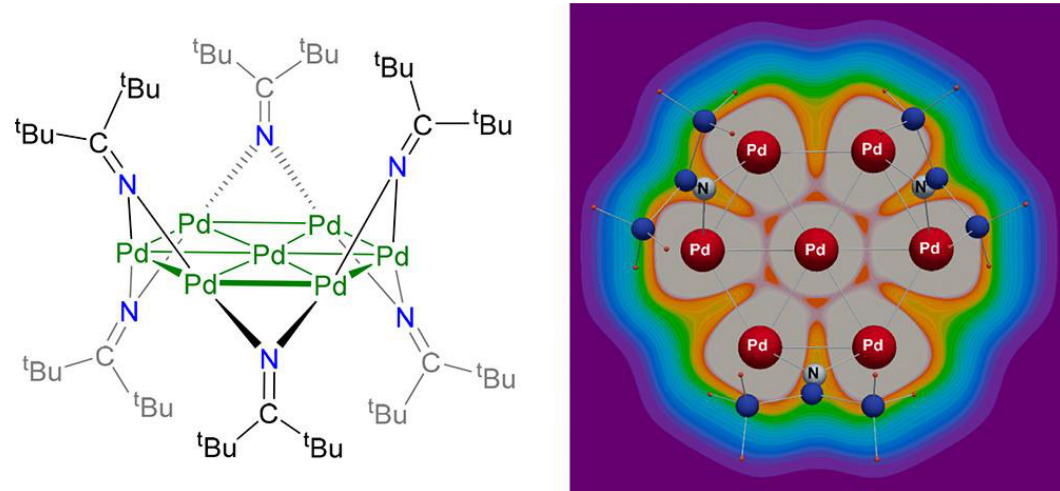
Figure 2. Hexagonal Pd 7 nanosheet stabilized by ketimine ligand [109]. Reprinted with permission from A. W. Cook, P. Hrobárik, P. L. Damon, G. Wu, T. W. Hayton, Inorg. Chem. 2020, 59, 2, 1471-1480. Copyright (2020) American Chemical Society (CSD Refcode PIDCID).